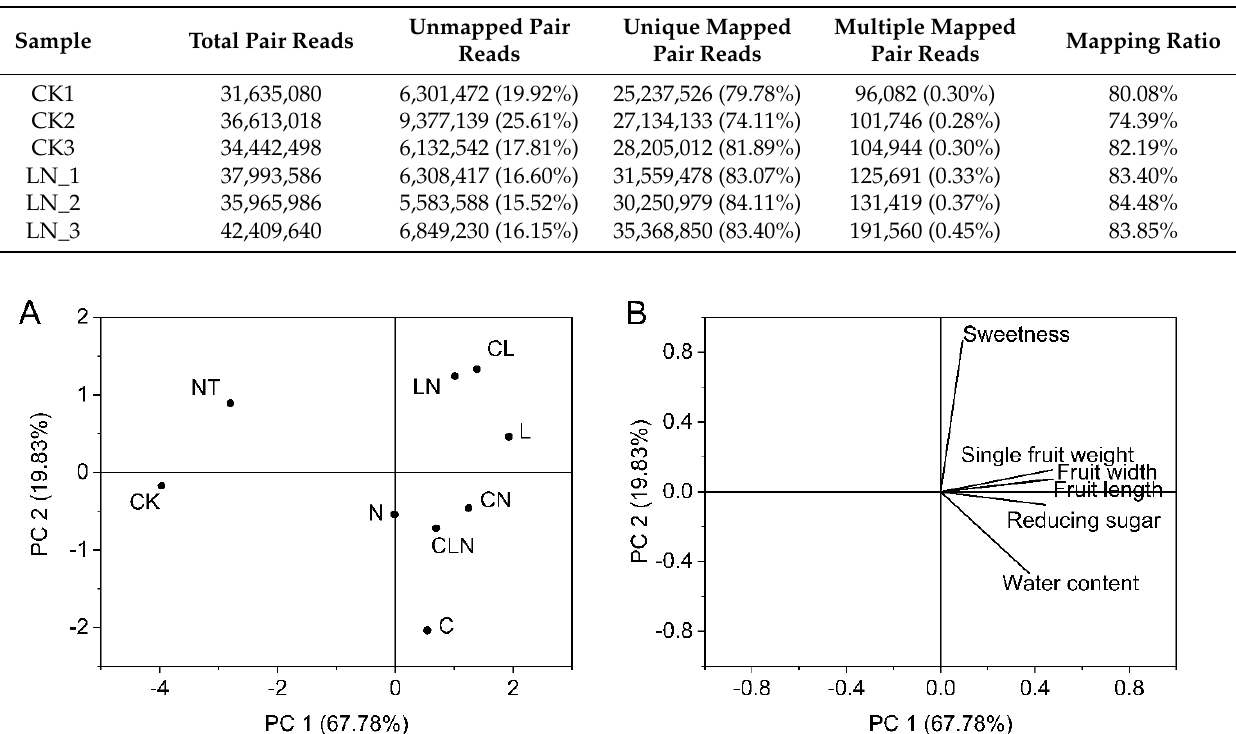
Table 6. Statistical table of comparisons with the reference genome after filtering rRNA.